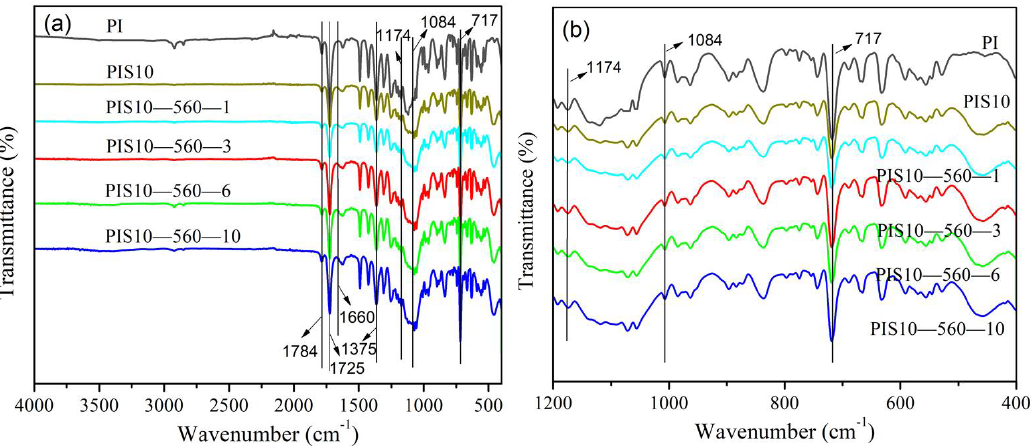
Figure 1. FTIR full spectra( a ) and partical larging spectra ( b ) of PI, PIS10, PIS10-560-1, PIS10-560-3, PIS10-560-6 and PIS10-560-10.